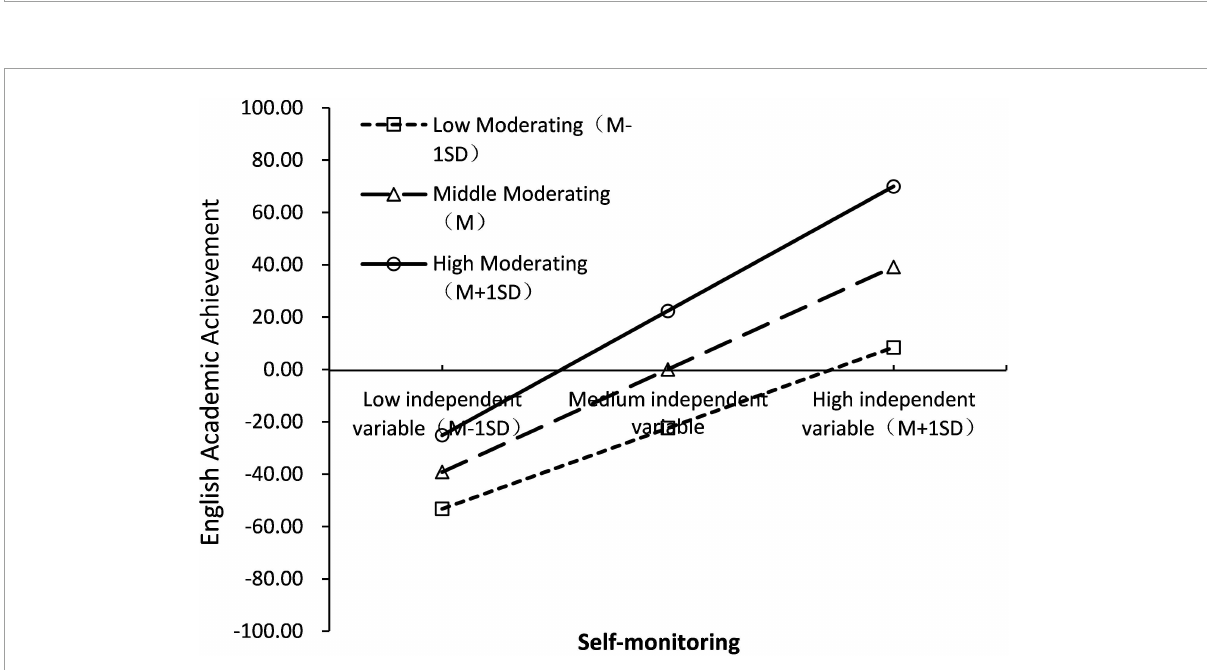
FIGURE7 Simple slope test (model